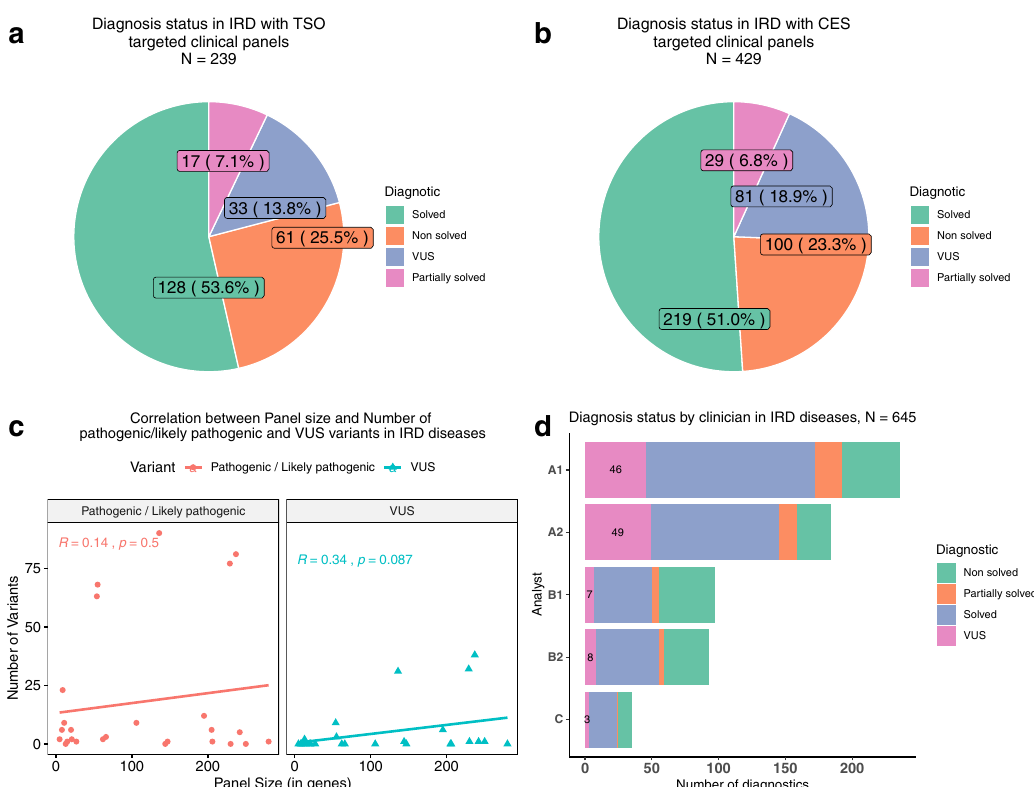
Fig. 2 NGS platform, gene panels, and analyst impact. Diagnostic status in IRD using TSO ( a ) and CES clinical exome panels ( b ). Correlation between IRD panels size used and number of VUS/ pathogenic-likely pathogenic variants found ( c ). Diagnosis status by analyst, 23 cases were analyzed by two analysts at the same time and were not considered in this analysis ( d